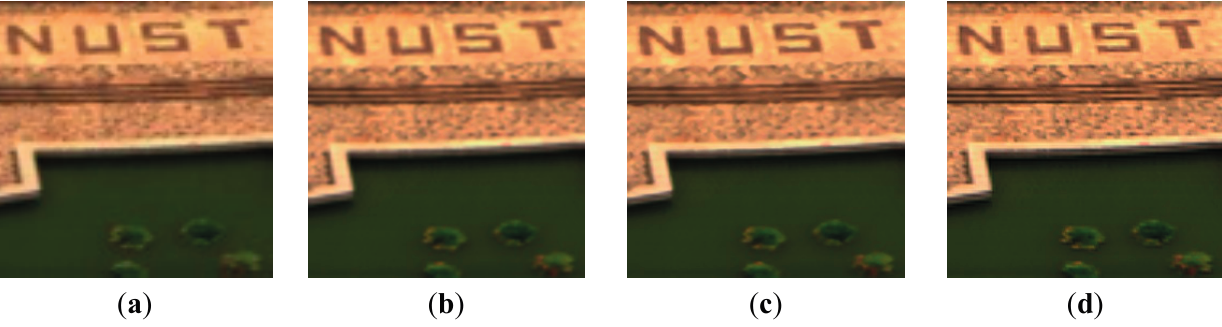
Figure 9. Experimental results of FS-NUST HSI dataset (color composite of R: 52, G: 32, B: 13). ( a ) original LR HSI; ( b ) bicubic interpolation method; ( c ) SR-SR method; ( d ) the proposed